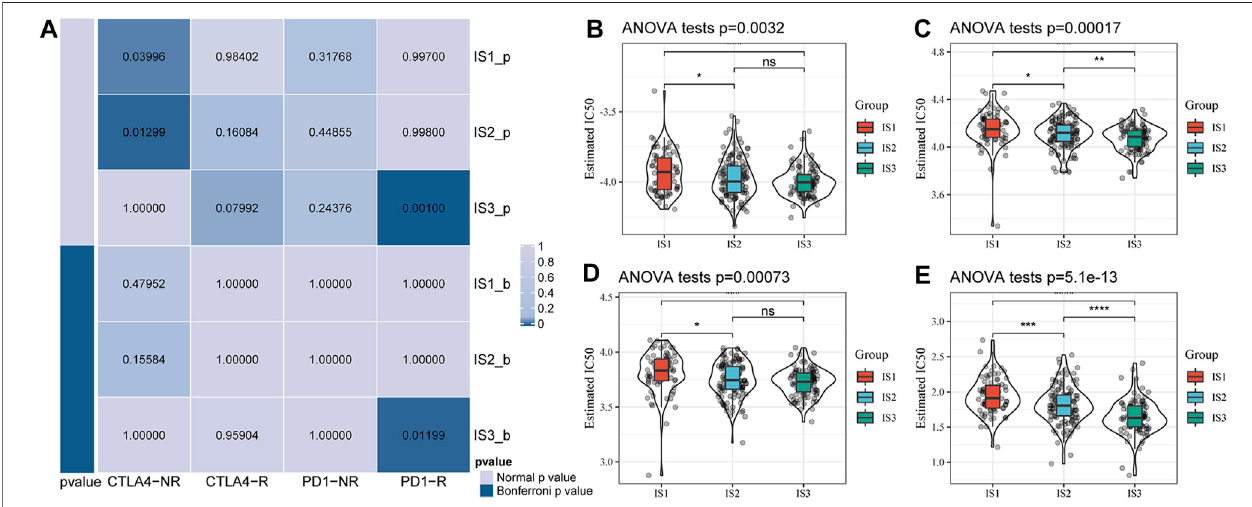
FIGURE5|(A) Submapanalysisshowedthat IS3couldbe more sensitive totheprogrammed celldeathprotein one inhibitor (Bonferroni-corrected p < 0.05).Box plots of the estimated IC 50 for paclitaxel (B) , veliparib (C) , olaparib (D) , and talazoparib (E) .